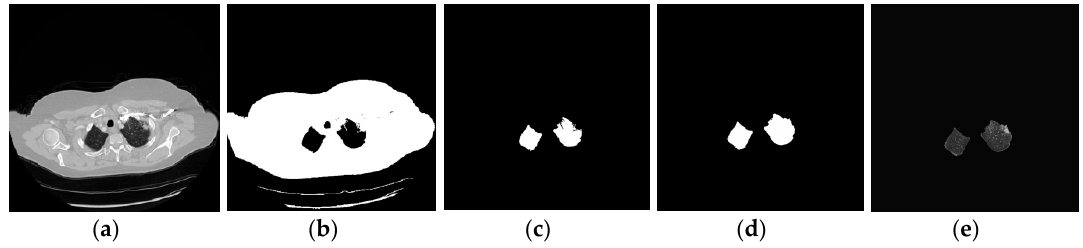
Figure 3. is one successful example of lung extraction while the nodule is linked to the pleura ( a ) CT image showing all the structures; ( b ) Binary image after the threshold; ( c ) Lung selection for extraction with area loos; ( d ) Lung completed after the application hole ‐ filling algorithm; ( e ) The lung extracted showing the internal structures.